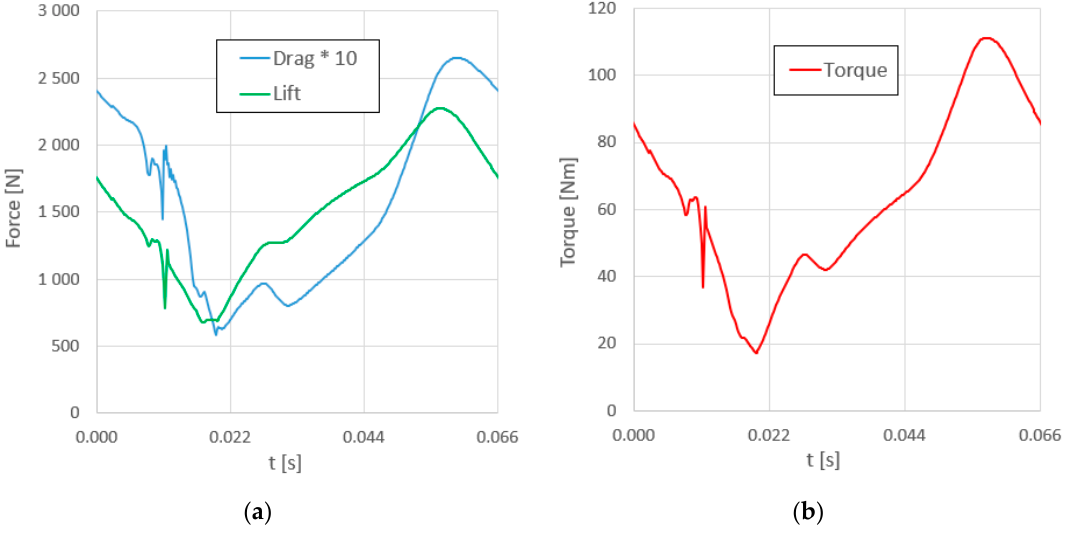
Figure 30. Aerodynamic loads calculated during one shedding cycle. ( a ) Drag and lift; ( b ) torque (axis at hydrofoil maximum thickness). Values of drag are increased ten times for better differentiation.